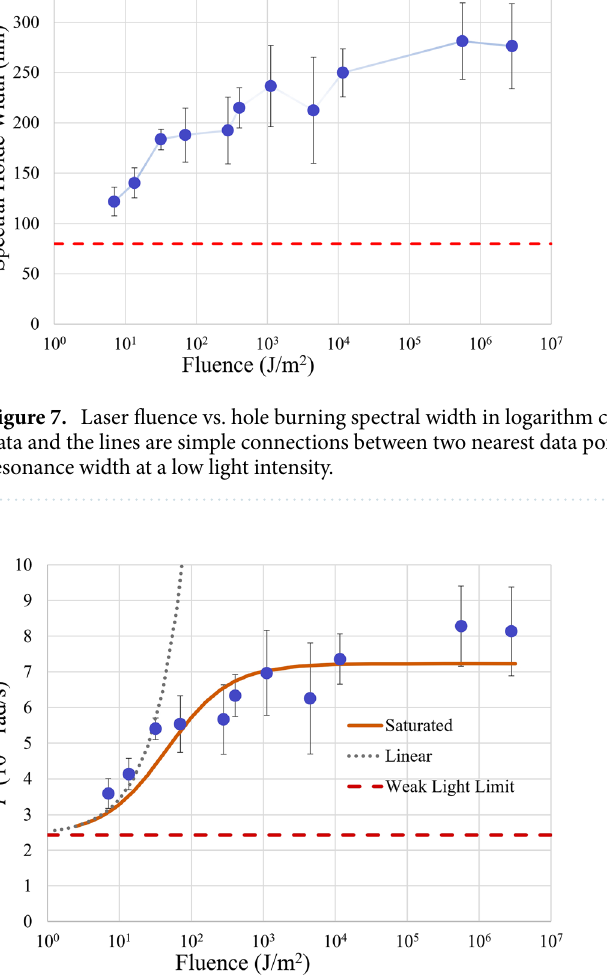
Figure 8. Laser fluence vs. damping coefficient Ŵ in logarithm coordinate. Dots are experimental results; the solid line represents a fitting with a saturation function; the dotted line represents a fitting with a linear function at low fluence and the dashed line represents damping coefficient at weak light